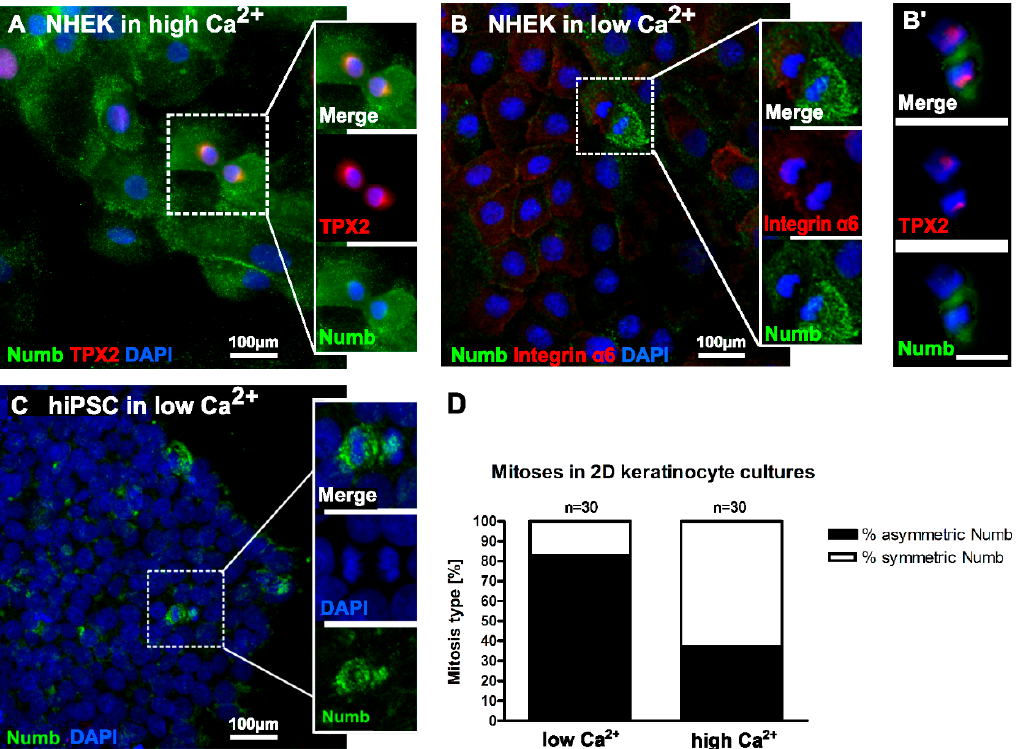
Figure 4. Differential distribution of Numb during mitoses depends on the differentiation state of NHEK. ( A ) In conventional culture in high Ca 2+ medium, Numb is rather evenly distributed throughout the cytoplasm with slight accumulation at the plasma membrane. Furthermore, during most mitoses, Numb is evenly distributed; ( B , B’ ) Under differentiation-inhibiting conditions in low calcium, Numb frequently displays an unequal distribution to the daughter cells during mitoses; ( C ) hiPSC in low Ca 2+ medium showed an overall reduced Numb expression. However, upon division, Numb was prominent, and the protein became unequally distributed between the daughter cells; ( D ) Quantification of mitoses with symmetric and asymmetric Numb distribution in NHEK cultures in low and high calcium medium. TPX2: Targeting protein for Xklp2; DAPI: 4 ′ ,6-Diamidin-2-phenylindol; Scale bars in B ’ and all insets 50 µm.